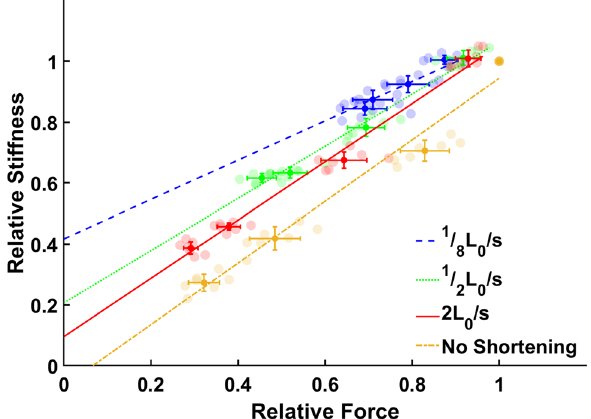
Figure 5. Relative force vs. relative stiffness at different active shortening velocities. Data points (n = 7 muscles per group) are means across muscles with error bars representing S.E. The slope and the y-intercept of the relative stiffness-force relationship differed significantly among shortening velocities, including ‘no shortening’ (ANCOVA, slope, p < 0.001; y-intercept, p < 0.001).